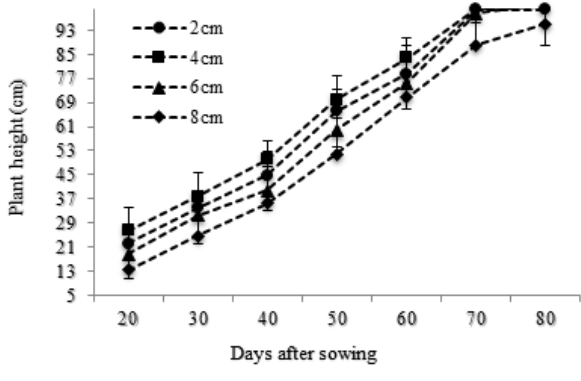
Figure 2: Seedling emergence as affected by sowing depth at diffe- rent days after sowing in wheat (average of 2 years). Mean (±SD) was calculated from three replicates for each treatment and significantly different at P ≤ 0.05 (LSD test).